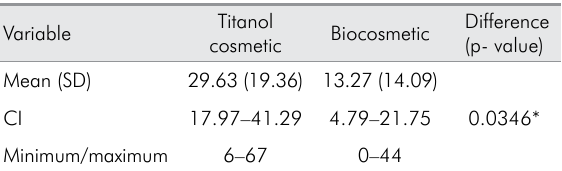
Table 2. Coating loss percentage after 21 days of oral cavity exposure.